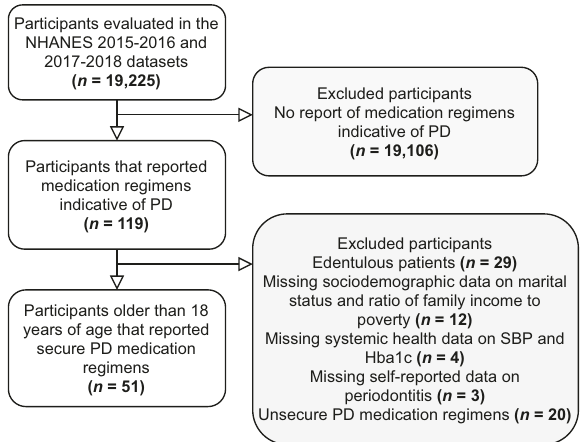
Fig. 1 Flowchart of patient inclusion. Data describes the steps involved in the inclusion of the fi nal sample with the number of patients and respective